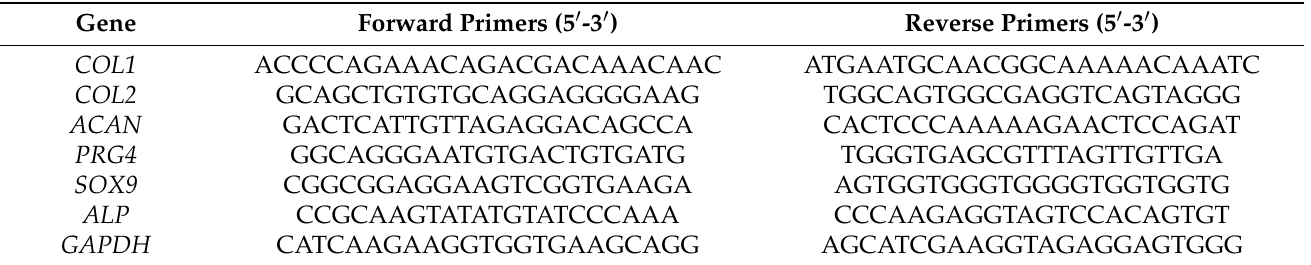
Table 1. Primer sequences are used in this